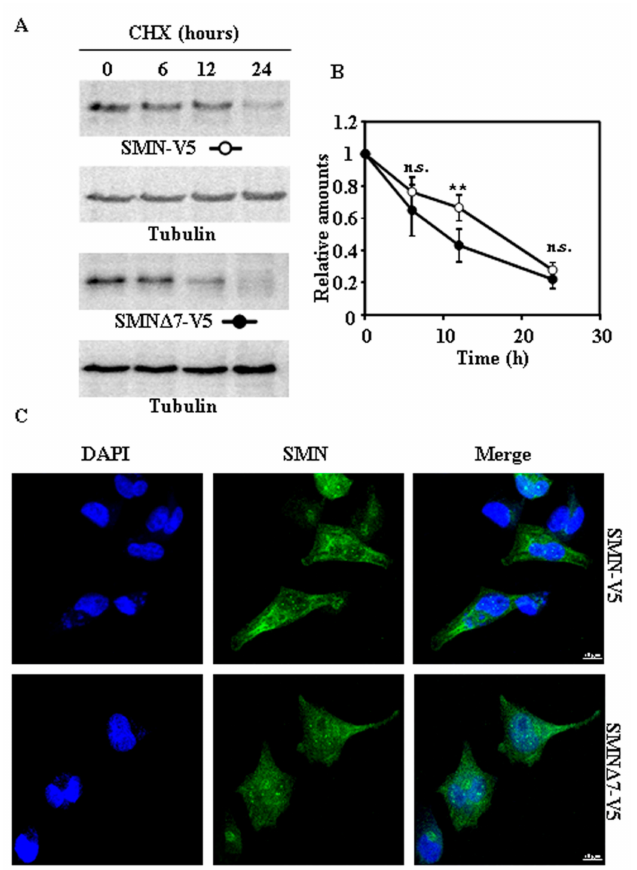
Figure 3. Degradation and subcellular localization of ectopically expressed SMN-V5 and SMN ∆ 7-V5 in HeLa cells. ( A ) HeLa cells were transiently transfected with SMN or SMN ∆ 7 tagged at the C-terminus with V5 and treated with CHX for the indicated times. Total cell lysates were analyzed by Western and immunoblot with anti-V5 specific antibodies. Anti-tubulin antibodies were used as total protein loading control. ( B ) Graph shows the quantification of protein levels referred to untreated cells as controls. ( C ) Confocal fluorescence images of SMN or SMN ∆ 7-V5 in transfected HeLa cells growing under basal conditions, analyzed by indirect immunofluorescence with anti-V5 specific antibodies (green channel) and counterstained with DAPI for nuclei visualization (blue channel). Bars = 10 µ m. Values are expressed as mean ± S.E.M. from at least three different experiments. Asterisks indicate a statistical significant difference between pairs (** p < 0.01, Student’s t -test). n.s., not